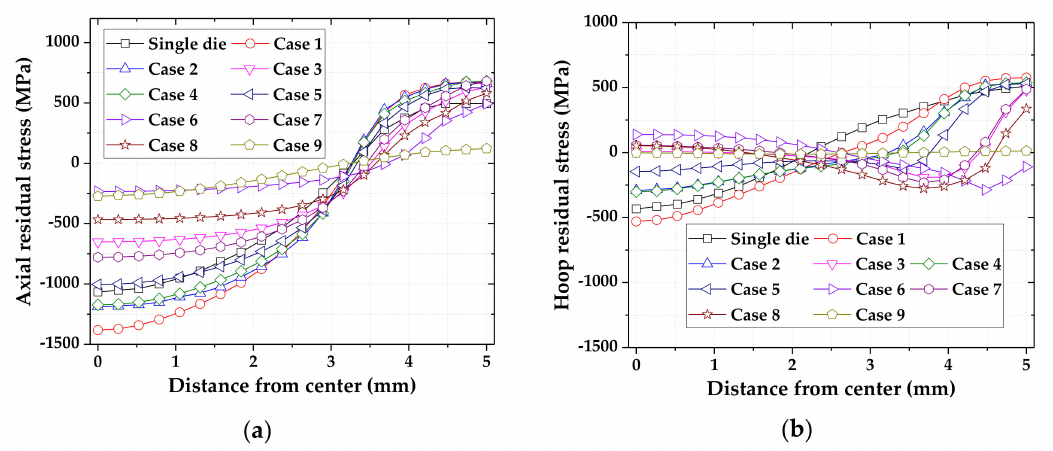
Figure 5. Residual stresses of drawn material by triple die tips according to R.A: ( a ) axial residual stress; ( b ) hoop residual stress.